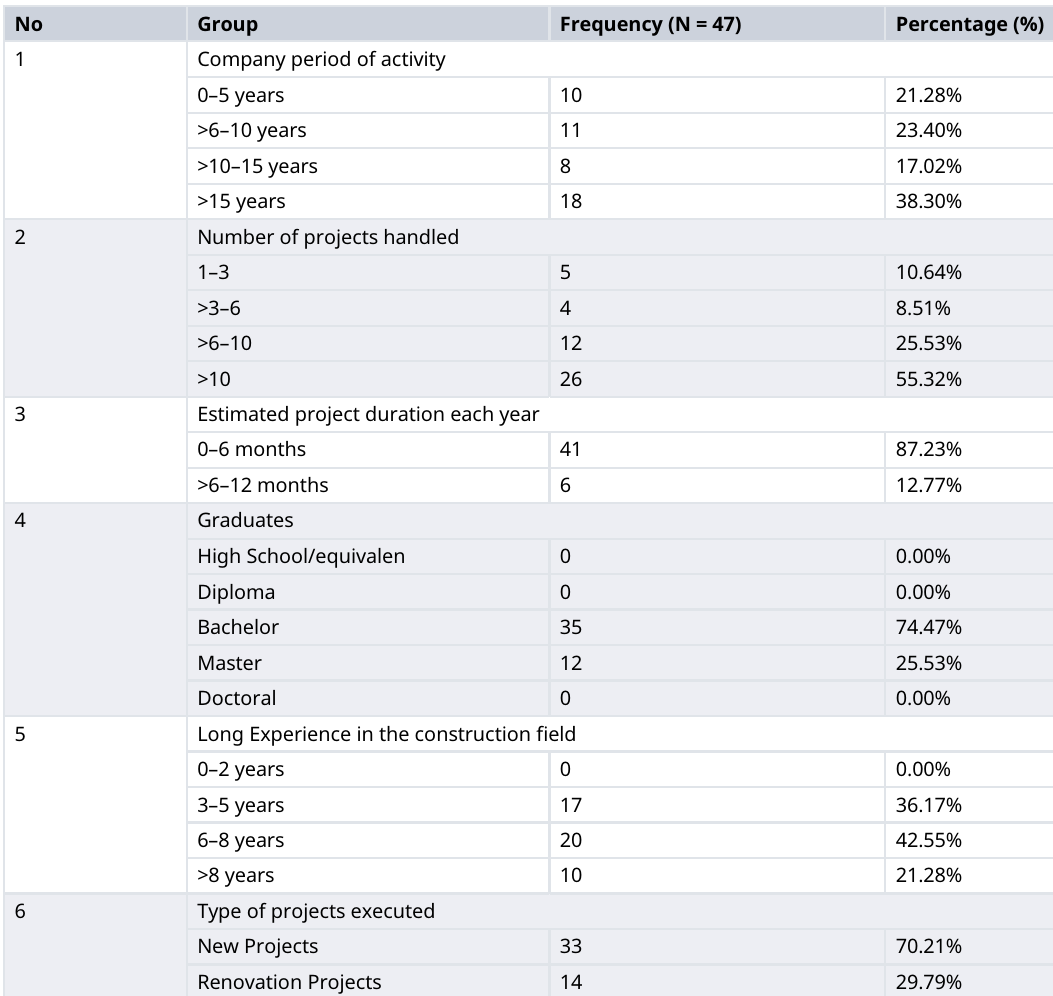
Table 4. Characteristics of respondents.